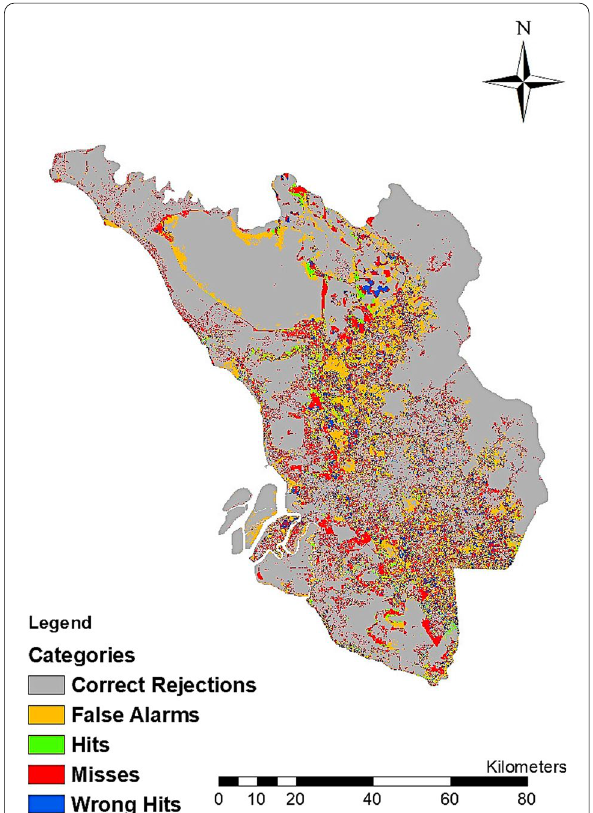
Fig. 6 The simulated land cover map of 2030